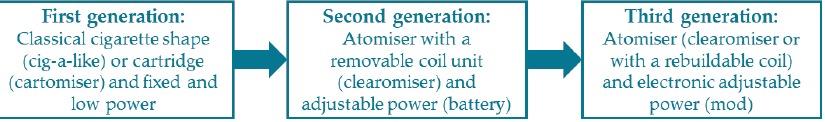
Figure 2. General characteristics of electronic cigarettes classification adapted from [2].